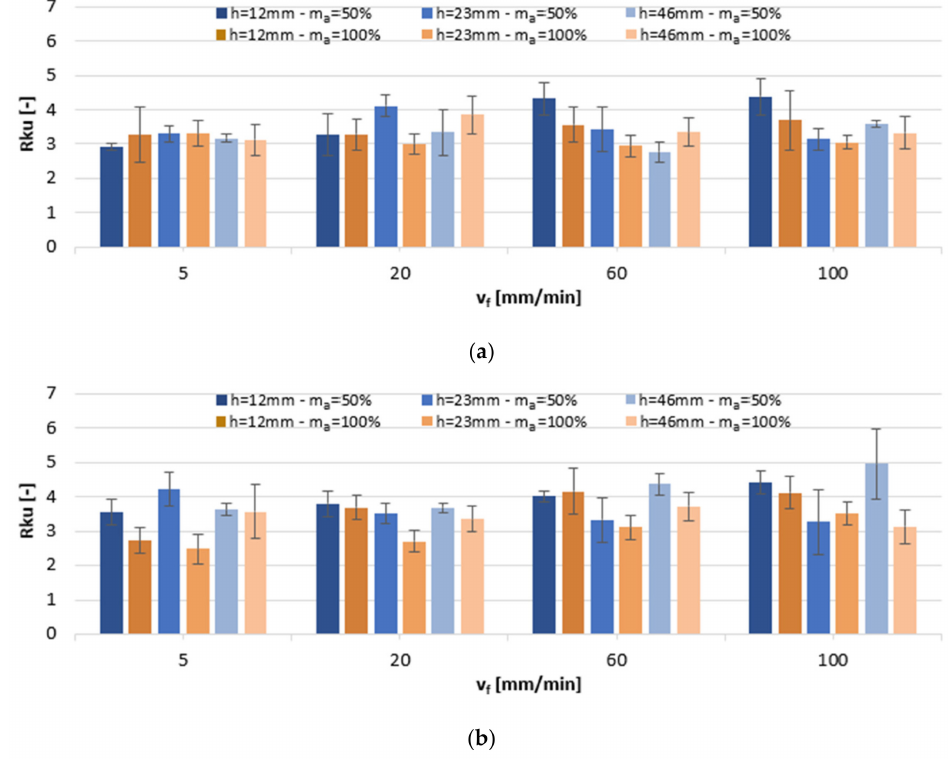
Figure 5. The impact of jet feed rate v f , sample height h, and abrasive flow rate m a on Rku of post-machined alloys: ( a ) AlSi10Mg and ( b )